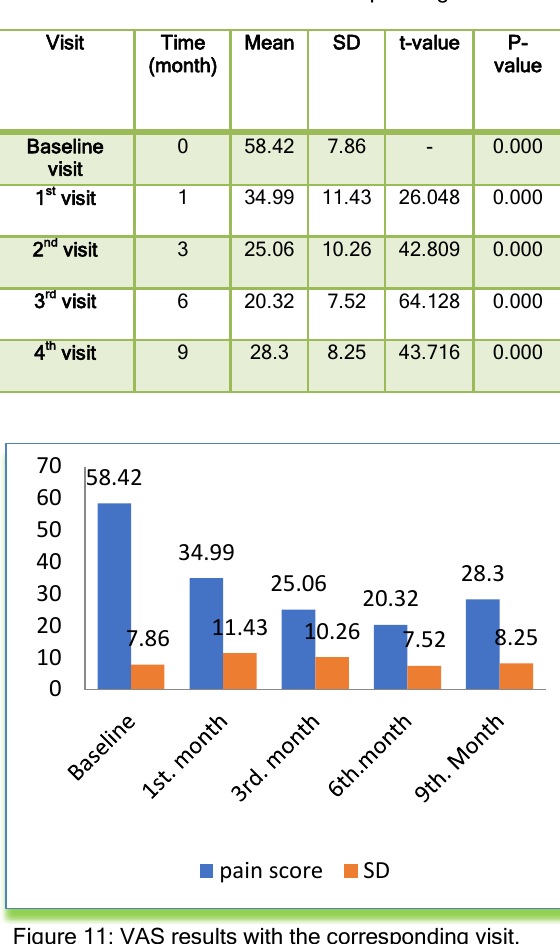
Figure 10: The patients demographic data. Table 2: VAS results with the corresponding visit